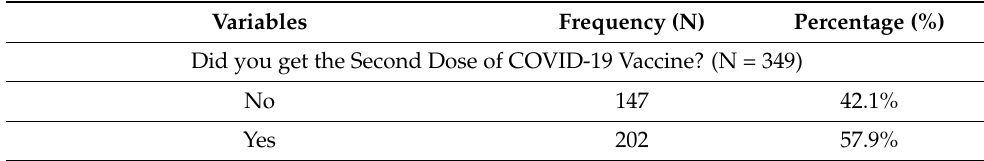
Table 4. Participants receiving the second dose of COVID-19